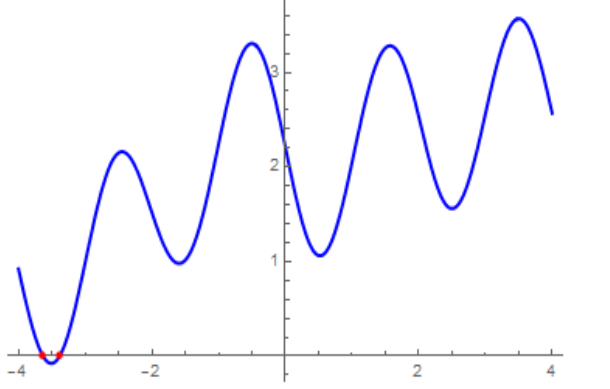
Figure 1. The plot of the nonlinear function in Experiment 4 along with its roots colored in red.